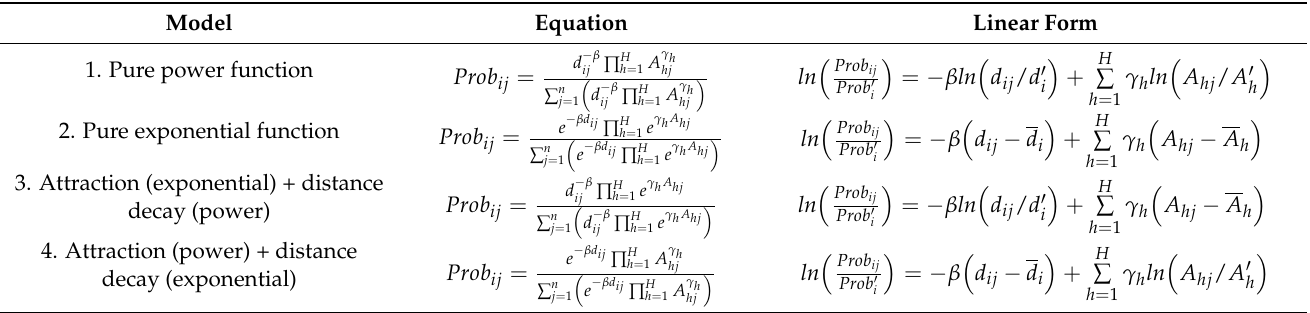
Table 1. Four extended forms of Huff model and their linear